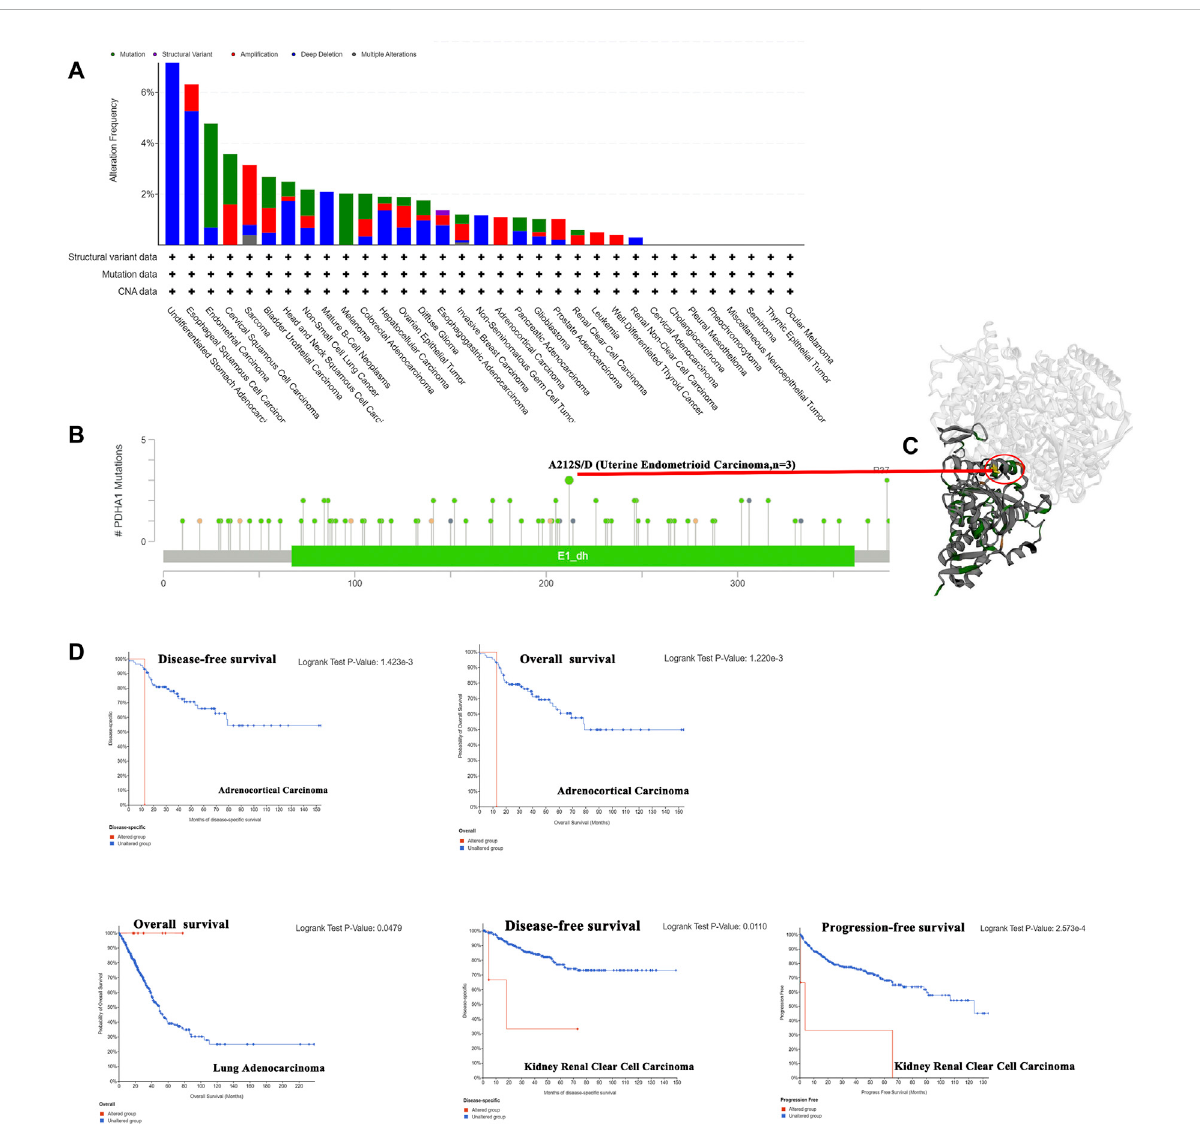
FIGURE 3 Genetic alteration of PDHA1 in pan-cancer. (A) Mutation status of PDHA1 in pan-cancers was performed by the cBioPortal tool. (B) Main mutationtypesofPDHA1. (C) A212S/Dmutationsitewasvisualizedinthe3DstructureofPDHA1protein. (D) RolesofPDHA1alterationinthepatients ’ prognosis, including OS, DFS, and